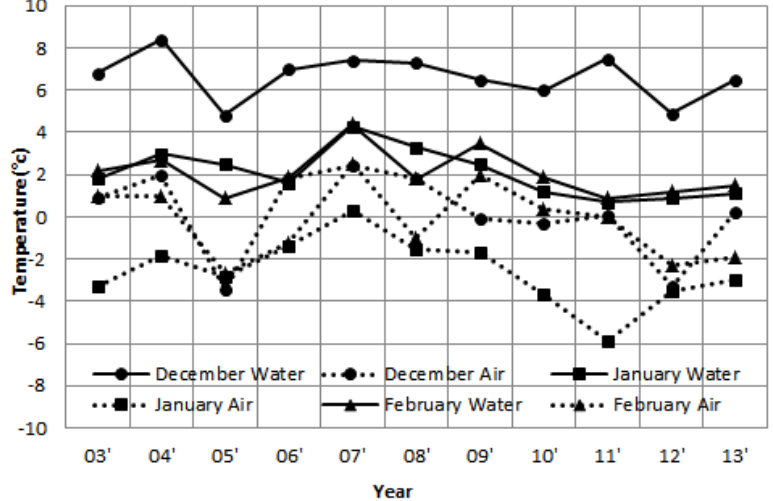
Figure 2. Variation of the monthly average sea water surface temperature and the air temperature on the sea during winter over 10